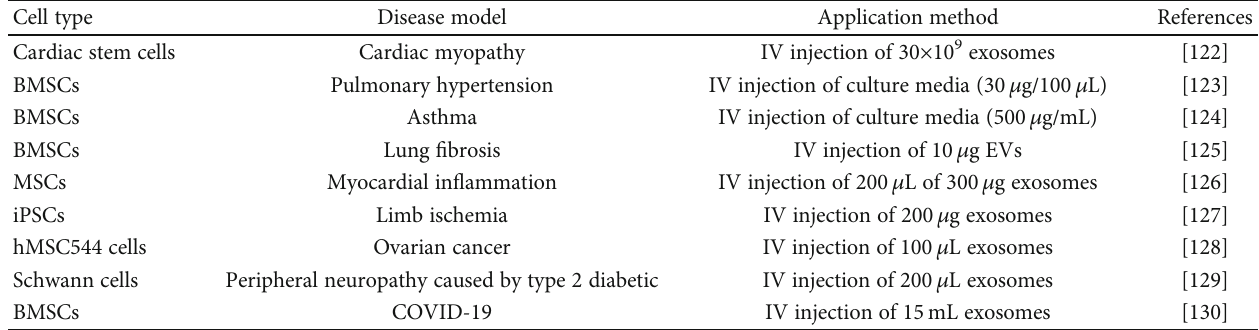
Table 1: Recent studies applied secretome and its components via intravenous (IV)